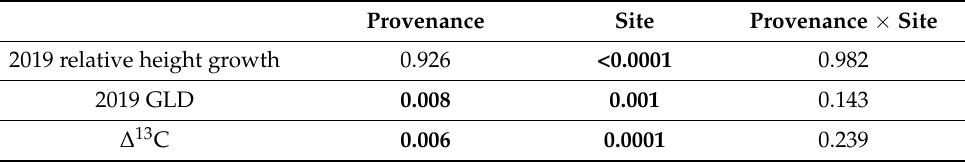
Table 3. p -value of seedling relative height growth, ground line diameter (GLD), and carbon isotope discrimination ( ∆ 13 C) for the provenance effect, planting site effect, and provenance × site interaction. Bolded values significant at p <